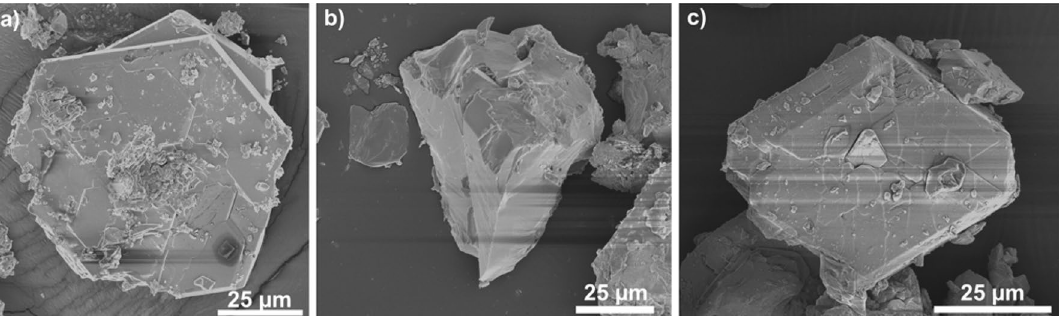
Figure 2. Scanning electron microscopy (SEM) images of ( a ) hexagonal AEPz-SnS-1, ( b ) irregularly shaped crystals of Sn